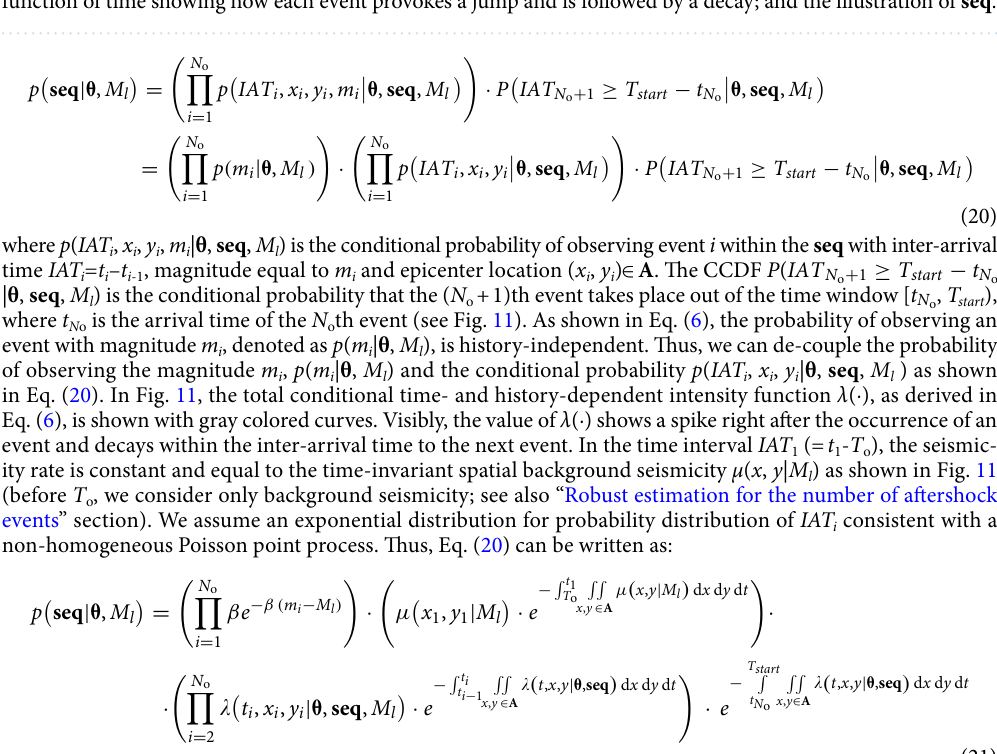
Figure 11. The main parameters required for constructing the likelihood function; the seismicity rate as a function of time showing how each event provokes a jump and is followed by a decay; and the illustration of seq